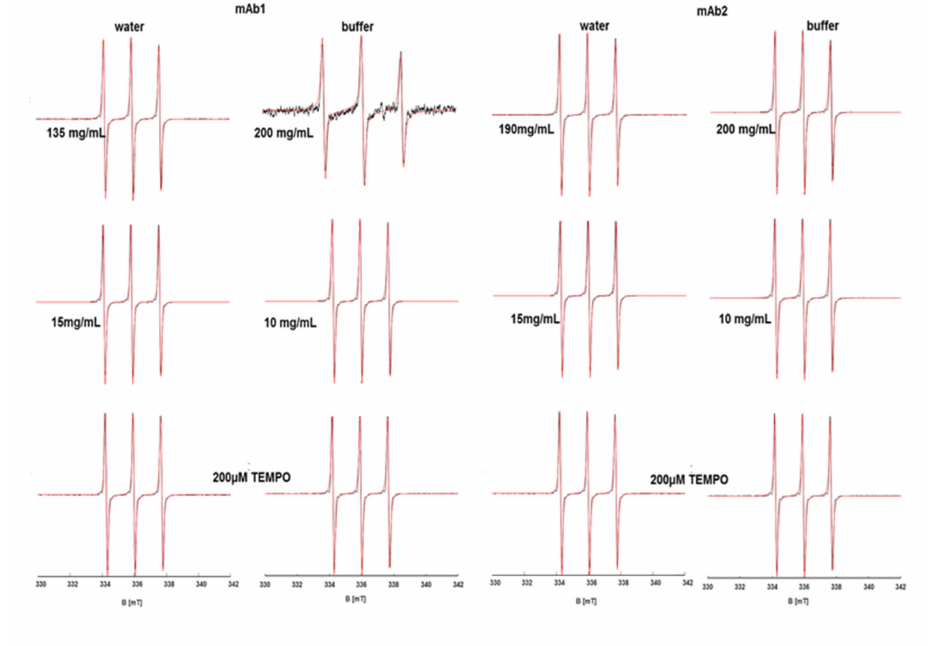
Figure 1. Experimental (black) and simulated (red) X-band CW EPR spectra of TEMPO in mAb1 and mAb2 solutions of di ff erent concentrations in pure water and bu ff er are shown. Also, the spectra of 200 µ M spin probe solutions in water and bu ff er as reference is